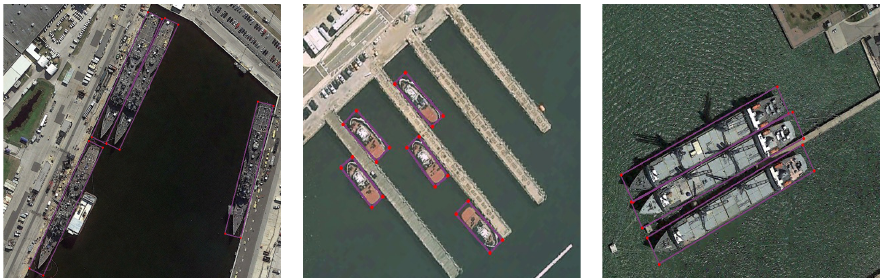
Figure 11. Visualization of the detection results of Point RCNN for the HRSC2016 test set. The score